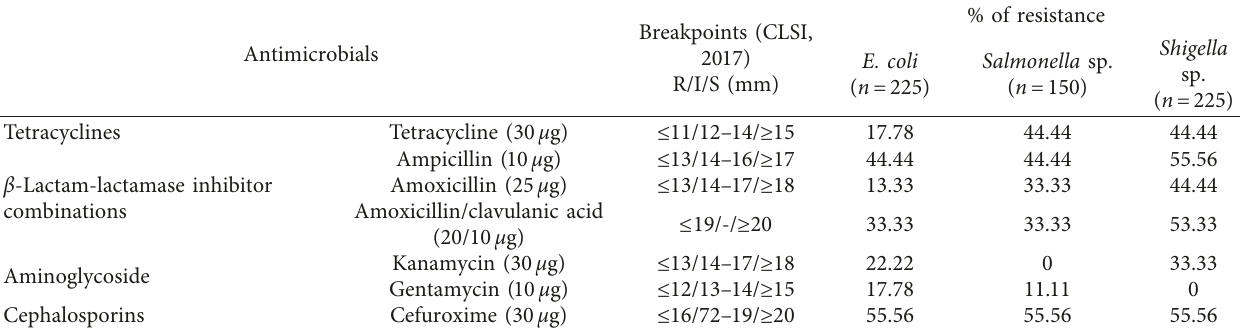
Table 1: Antibiotic susceptibility of bacteria originated from raw beef meat.